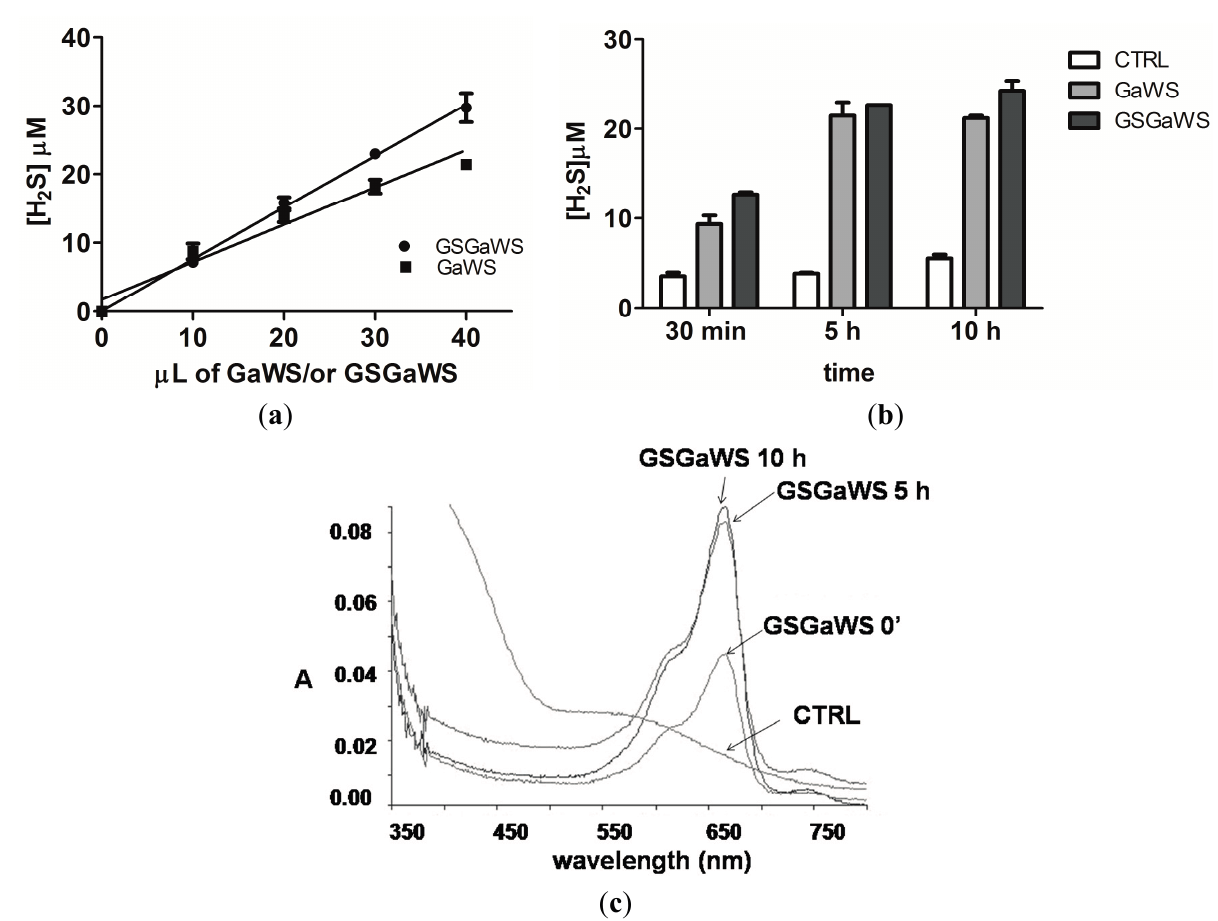
Figure 4. H 2 S production by garlic-WS extracts (cold extractions) obtained ( a ) at different concentrations of GaWS and GSGaWS; ( b ) H 2 S formation over time by 5 μ L of GaWS (0.16 mg) and of GSGaWS (0.22 mg) in the presence of 4 mM DTT; ( c ) UV-vis spectra of the solution after 30 min, 5 h and 10 h of incubation at 37 °C. Each bar represents ±SD of three or five